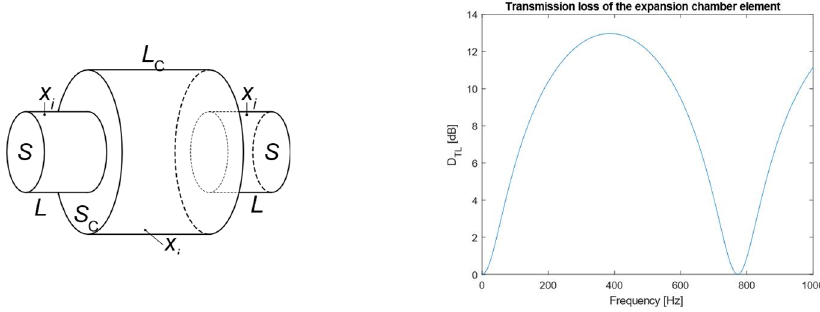
Figure 4. Expansion chamber sketch ( left ) and example of TL obtained with TMM ( right ).